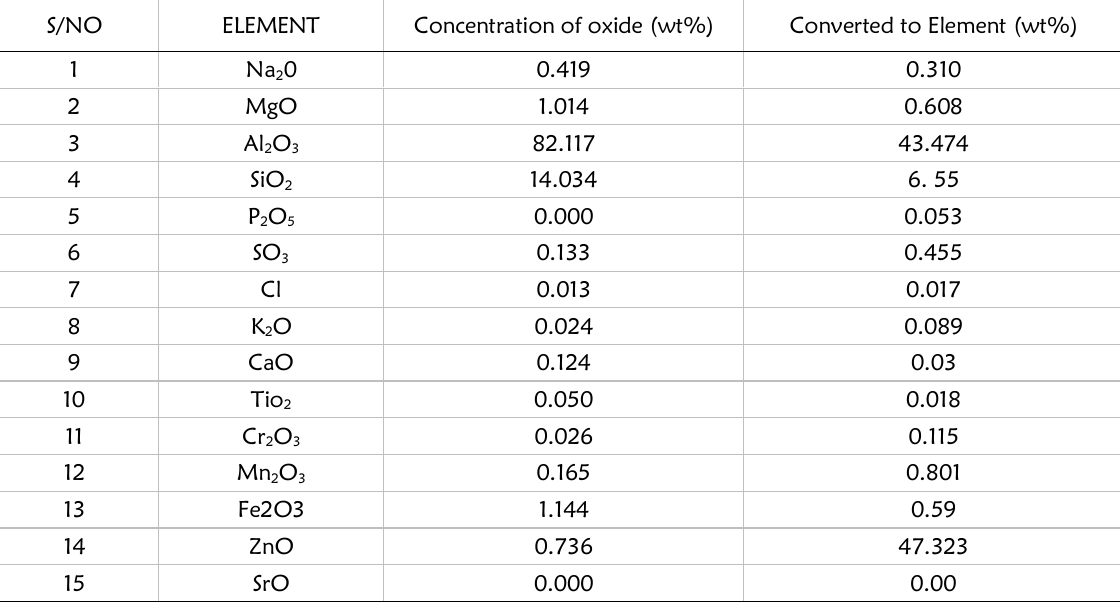
Table 6: Elemental Composition of Sample (motorcycle hub) using (XRF)